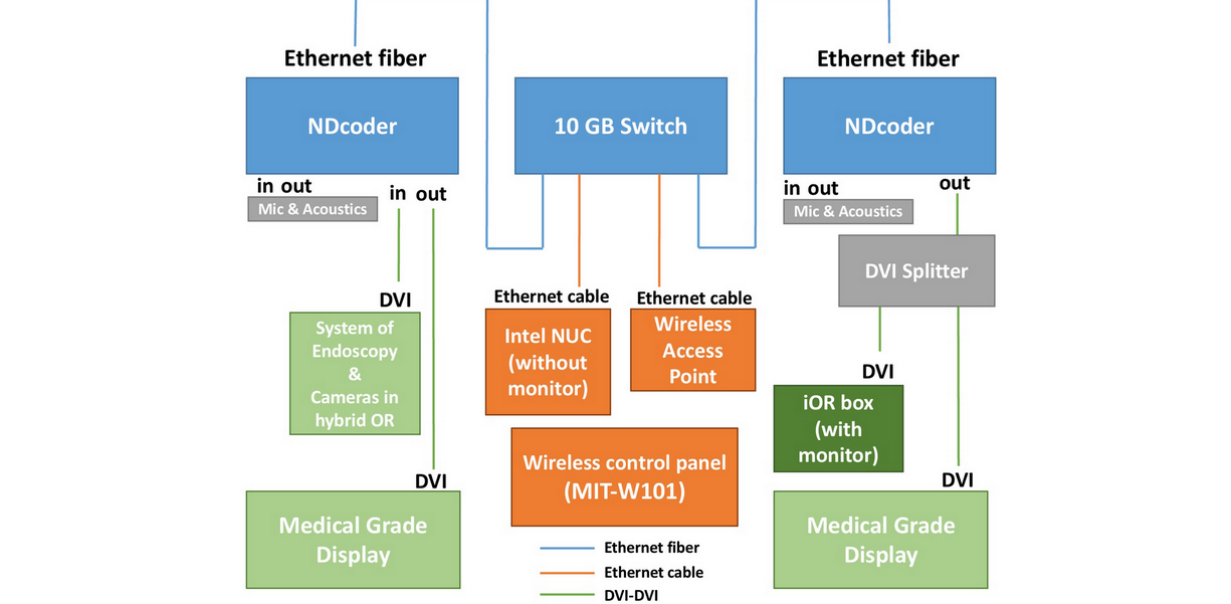
Figure 2. The map of the intelligent operating room system. DVI: digital video interface; iOR: intelligent operating room; NUC: next unit of computing.